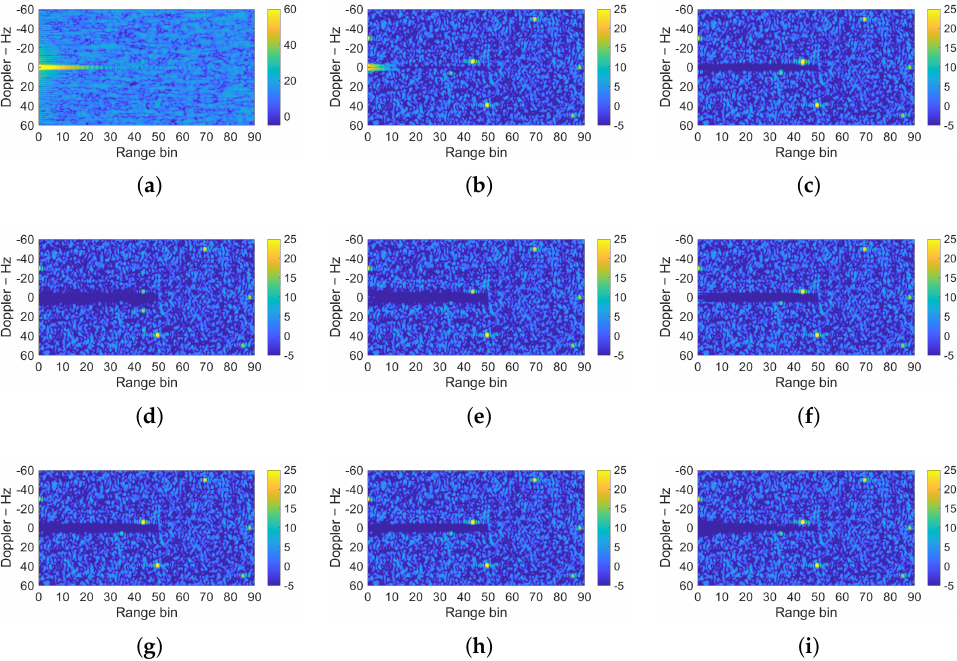
Figure 5. Two-dimensional cross-correlation function of different ECA versions. ( a ) Without suppres- sion. ( b ) ECA without extension. ( c ) ECA with extension. ( d ) ECA-B. ( e ) ECA-S. ( f ) ECA-CF-PC. ( g ) ECA-LF-PC with symmetric weights. ( h ) ECA-LF-PC with asymmetric weights. ( i ) ECA-LF-PC with varying weights.